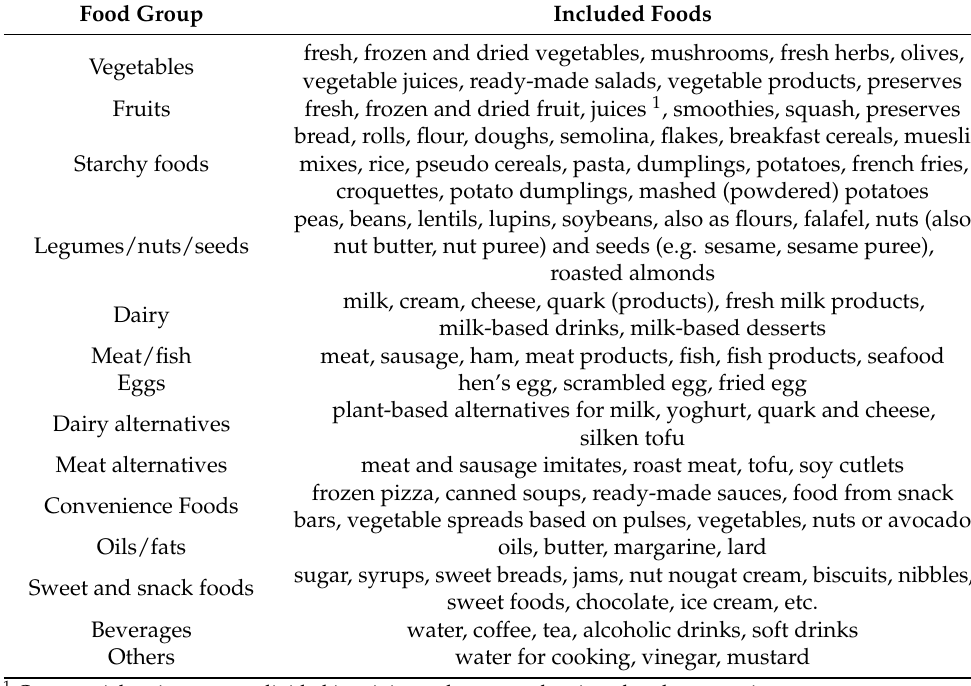
Table 1. Classification of food groups (modified according to Alexy et al.